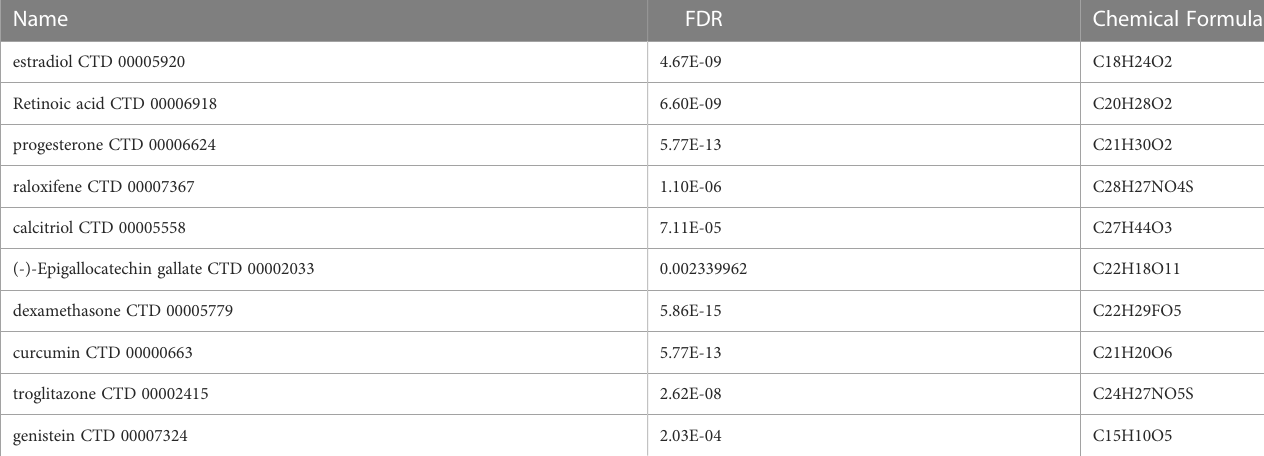
TABLE 1 List of the top 10 potential chemical compounds for COVID-19 and IBD.